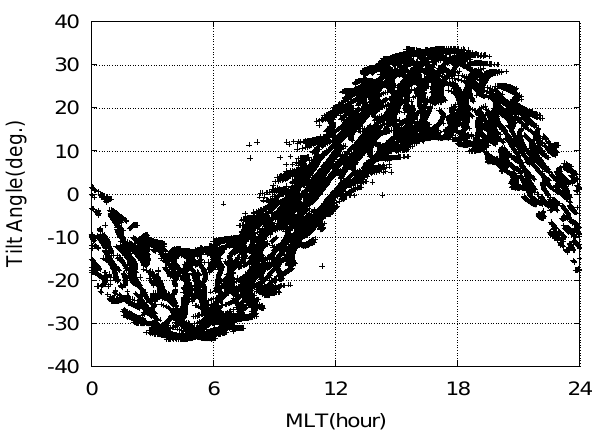
Fig. 5. Relationship between MLT of spacecraft locations and tilt angle in perigee passes. Each data point consists of 5-min average values in our database.